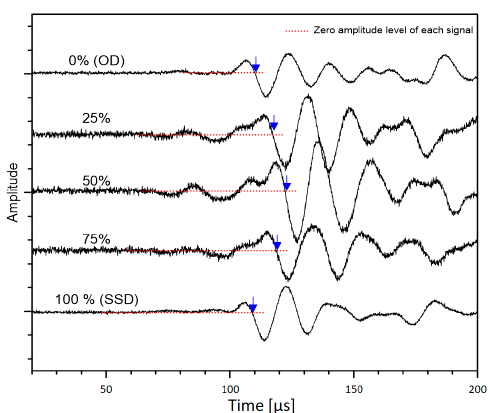
Figure 5. Typical time signals of ultrasonic pulse waves (shear wave propagating through concrete cylinders at different saturation levels, measured by a pair of the dry contact S wave